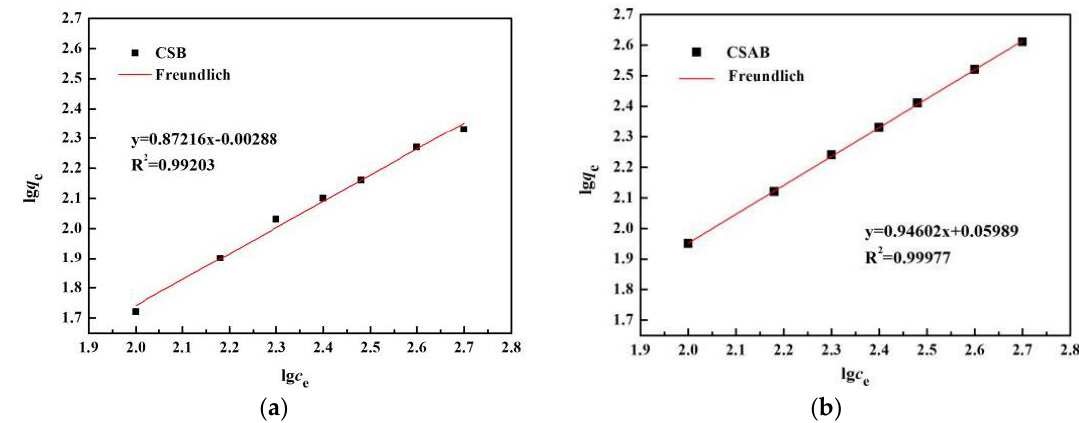
Figure 12. Freundlich isothermal adsorption equation fitting of diesel oil onto: ( a ) CSB, ( b ) CSAB.